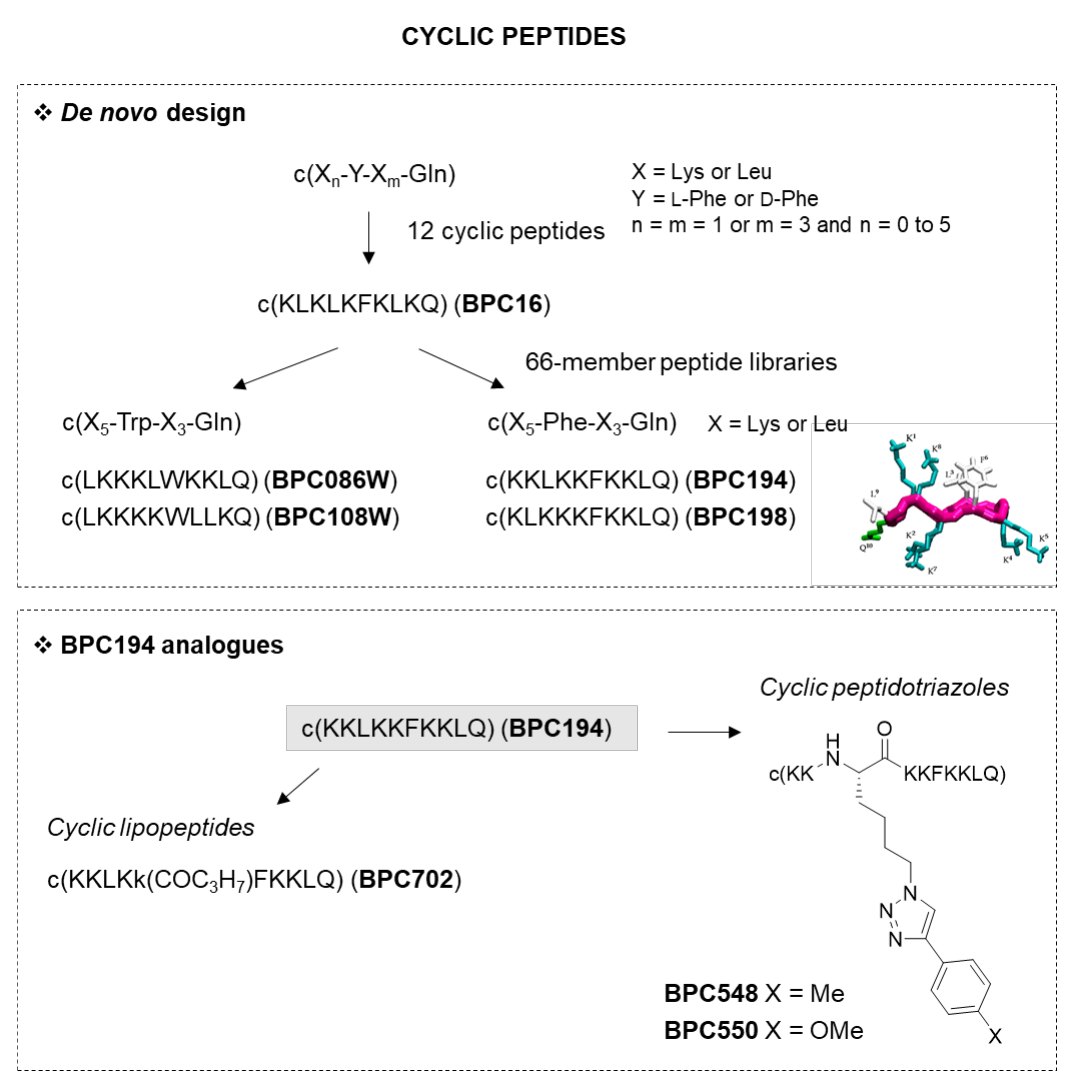
Figure 2. Cyclic peptides. De novo design of cyclic peptides [48 – 51], identification of leads and design of BP194 analogues [49,52 – 55], as described in Section 2.1. Table 1. Antimicrobial activity (minimum inhibitory concentration, MIC) and hemolysis of selected linear and cyclic peptides.